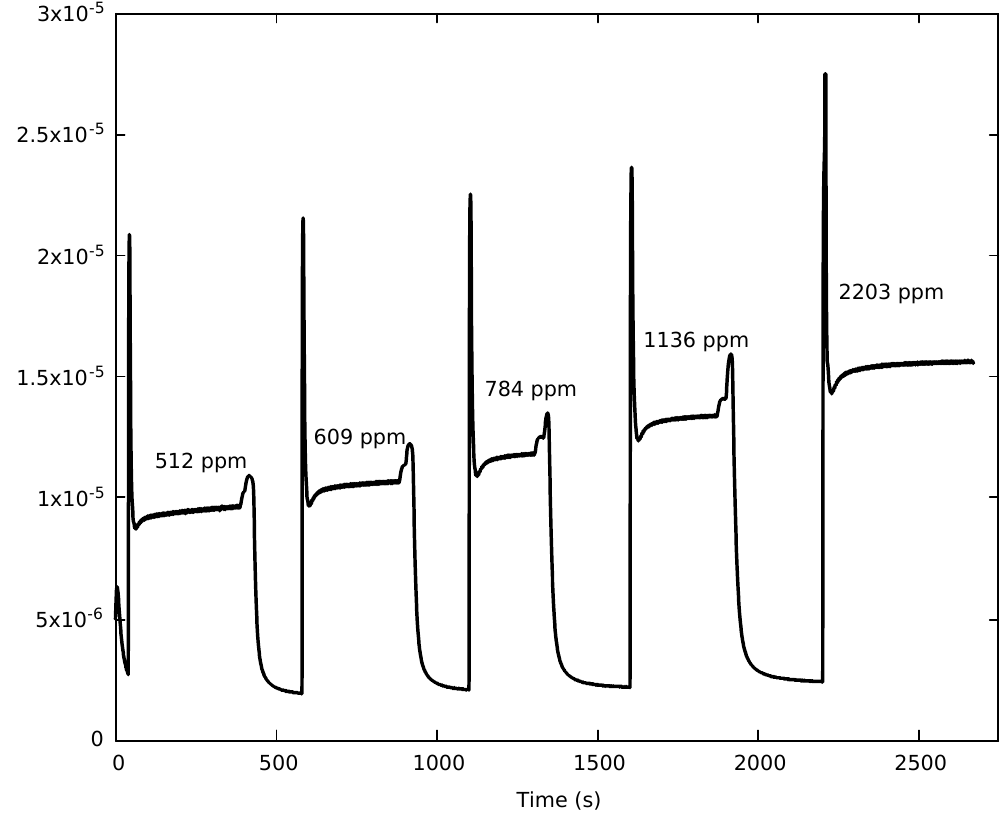
Figure 3. The MQ-4 response to difference CH Instruments, Inc. ZRE Non-Dispersive Infrared